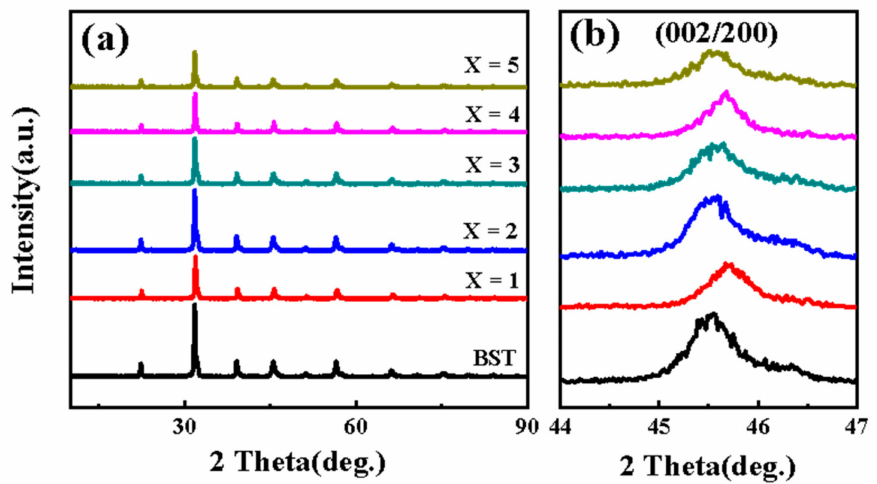
Figure 1. ( a ) XRD patterns of BST and BST- x mol% MgO ( x = 1, 2, 3, 4, 5) powders. ( b ) Magnification of the patterns shown in ( a ) at the range of 44 ◦ to 47 ◦ . Table 1. Lattice parameters of the BST and BST- x mol% MgO ( x = 1, 2, 3, 4, 5) powders.